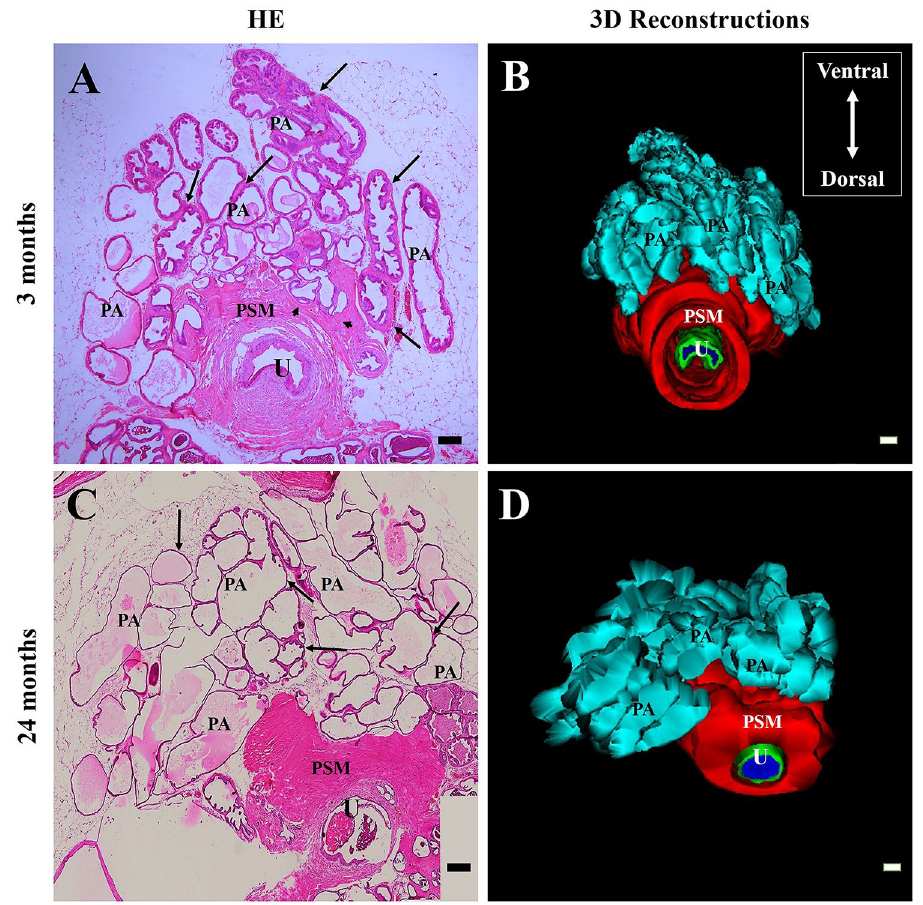
Figure 1. Histological sections of the adult (3 months old) and senile (24 months old) Mongolian gerbil ventral prostate stained with H&E and 3D reconstructions of these histological sections. ( A ) In the adult prostate, the prostate alveoli have thick layers of stratified smooth muscle in the perialveolar region and the periurethral smooth muscle is continuous with the perialveolar smooth muscle of some alveoli. ( B ) The epithelium of the alveoli of adult ventral prostate is often folded, which indicates intense activity of synthesis of prostate secretion. ( C , D ) In the elderly prostate, alveoli are dilated, usually not folded, and thin layers of perialveolar musculature are present. PA, cyan (Prostate alveoli), Arrow (Layers of smooth muscle in the perialveolar region), Arrowhead (Continuity between the periurethral and perialveolar smooth muscle layers), PSM, red (Periurethral smooth muscle), U, green (Urethra), bar (200